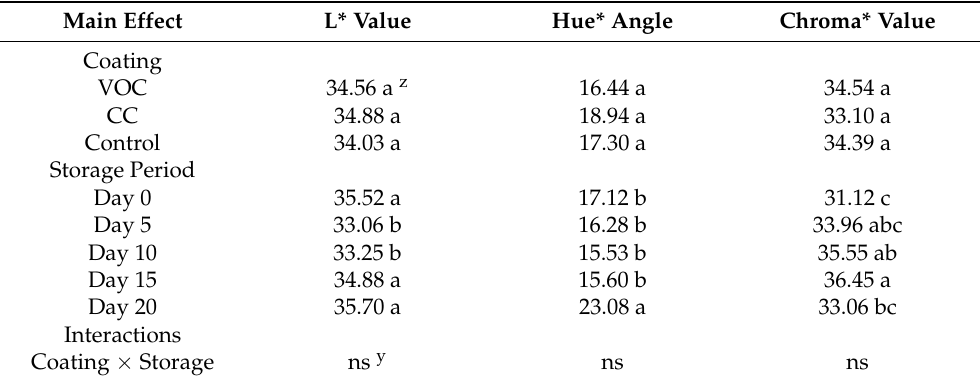
Table 2. Main effects and interactions for external color of whole, coated and uncoated pitaya fruit during 20 days storage at 7 ◦